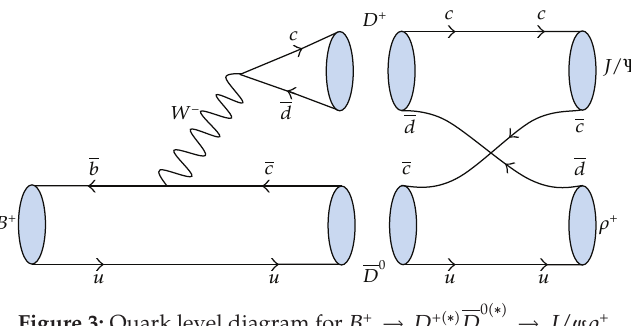
Figure 3: Quark level diagram for B (cid:2) → D (cid:2)(cid:3) ∗ (cid:4) D